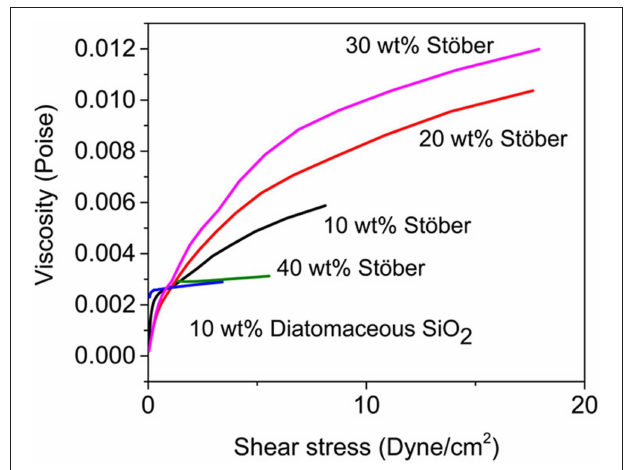
FIGURE 3 | Viscosity as a function of shear stress for various SAFIRE electrolytes. Reprinted with permission from Veith et al. (2017). Copyright (2017) American Chemical Society.